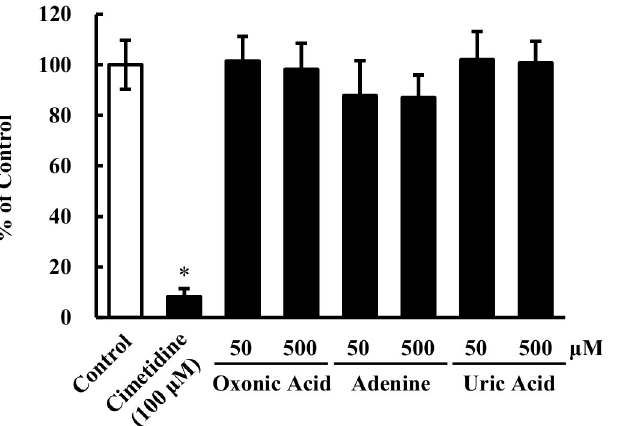
Fig 6. Effects of oxonic acid, adenine and uric acid on uptake of MPP + by MATE1-expressing cells. Uptake of [ 3 H] MPP + (2.5 nM) by HEK293/MATE1 and HEK293/mock cells was performed at 37˚C for 0.5 min in the absence or presence of oxonic acid, adenine or uric acid. Cimetidine was used as a positive control of Mate1 inhibitor. Data are presented as mean ± SEM (n = 3). � p < 0.05 vs. control rats (Dunnett’s test).